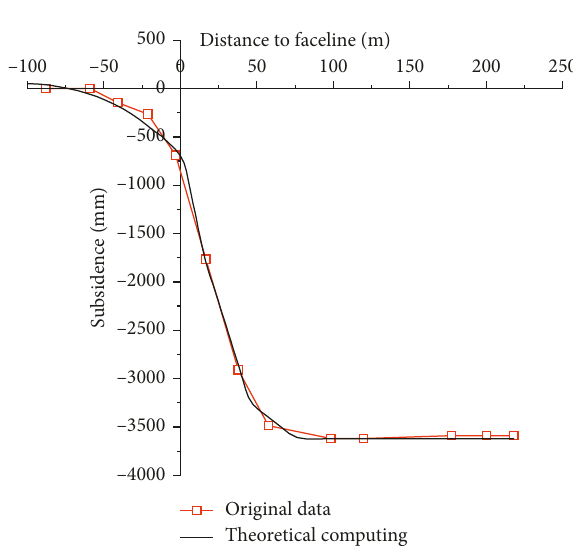
Figure 16: Subsidence of the surface measurements and the theoretical calculations.